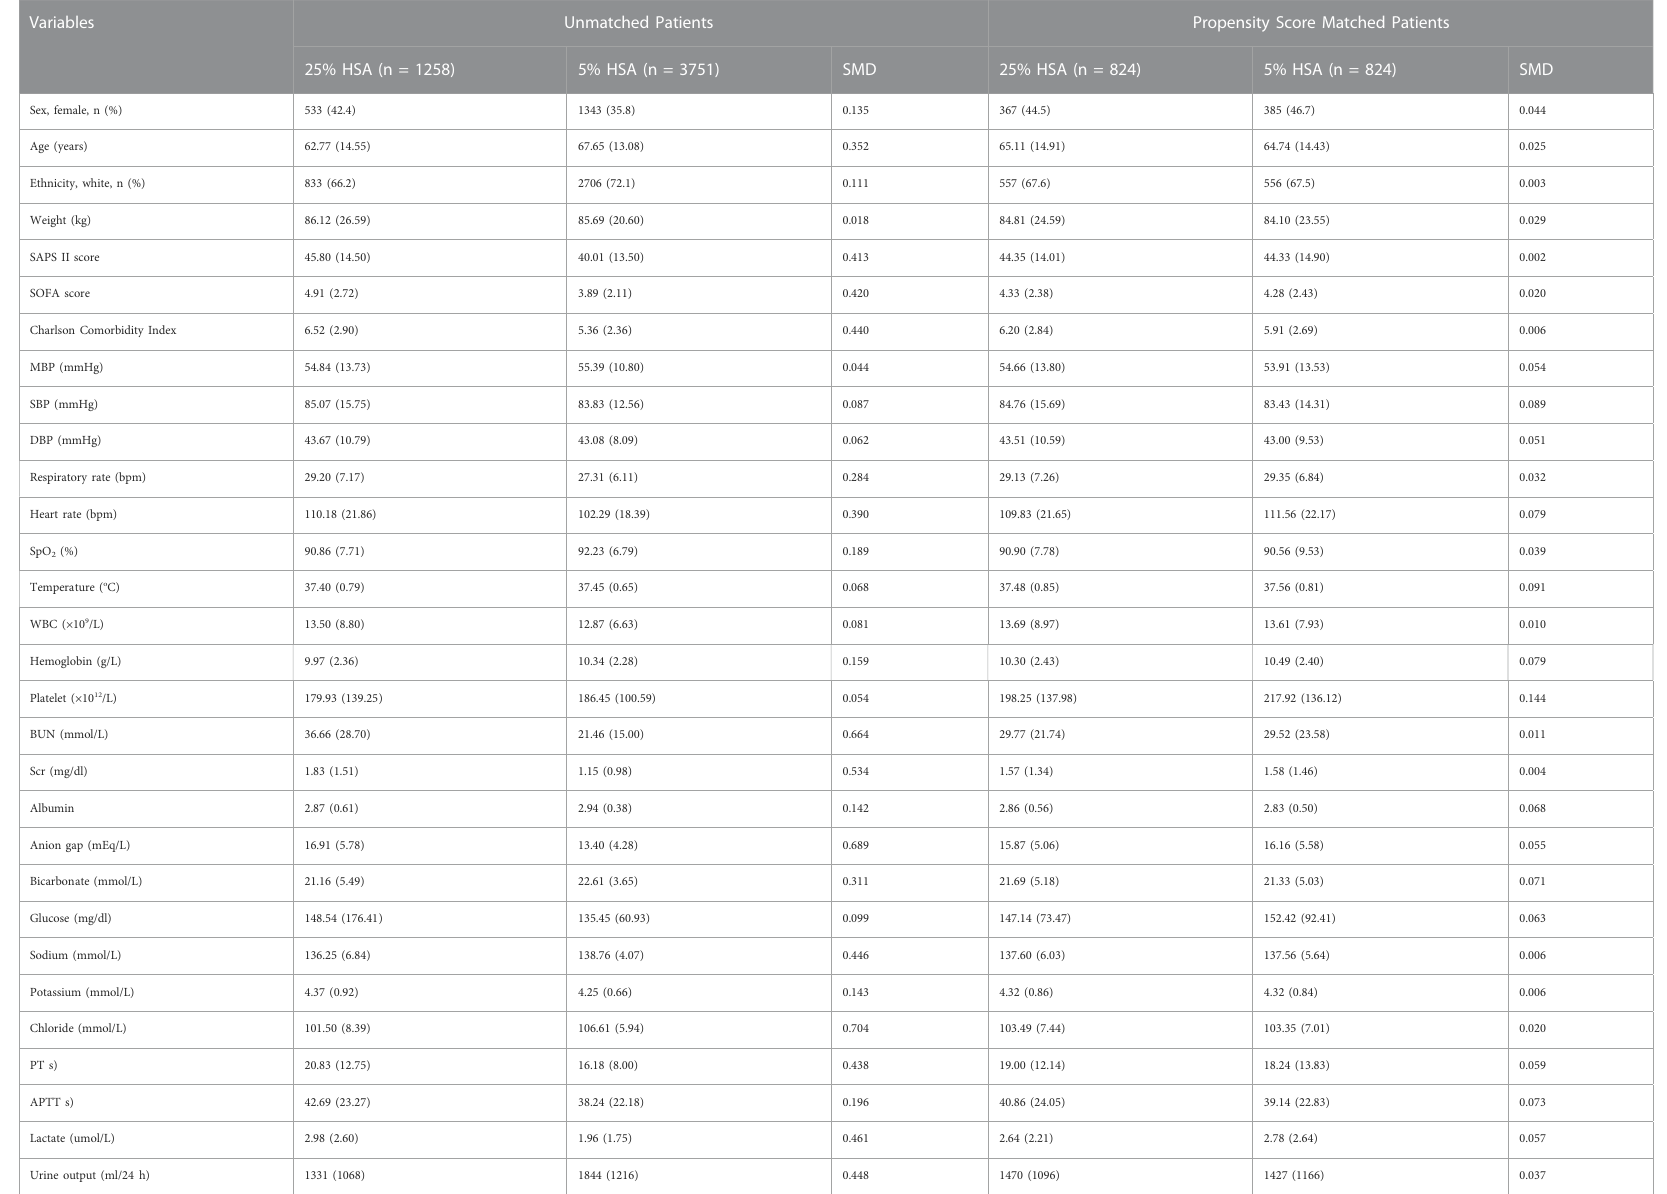
TABLE 1 Demographics and baseline characteristics of patients before and after propensity score matching.